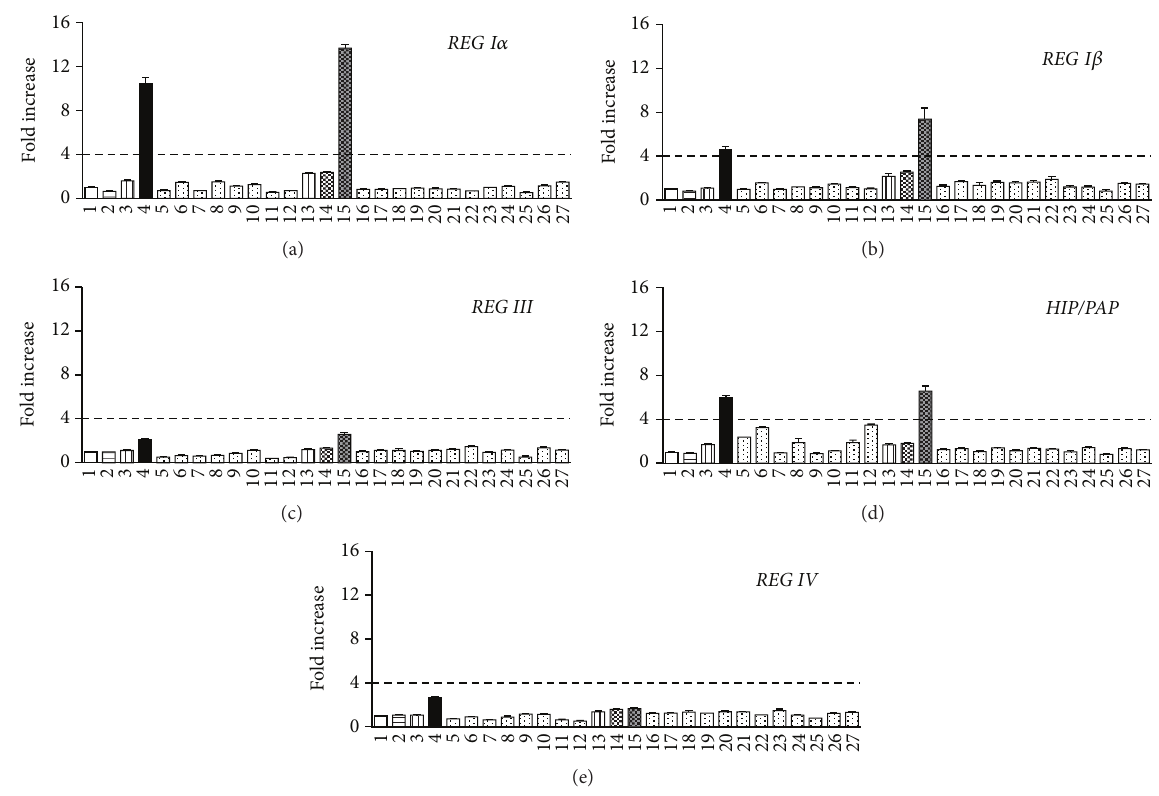
Figure 1: Effects of cytokines, 𝛽 -cell toxic agents, and growth factors on the transcription of (a) REG I 𝛼 , (b) REG I 𝛽 , (c) REG III, (d) HIP/PAP , and (e) REG IV in human 1.1B4 𝛽 cells. Cells were transfected with the human REG family gene reporter plasmids and treated as follows: 1, No addition; 2, Dx (100 nM); 3, IL-6 (20 ng/mL); 4, IL-6 + Dx; 5, IL-1 𝛽 (300 U/mL); 6, IL-1 𝛽 + Dx; 7, TNF- 𝛼 (370U/mL); 8, TNF- 𝛼 + Dx; 9, IFN- 𝛾 (100U/mL); 10, IFN- 𝛾 + Dx; 11, IL-1 𝛽 (60U/mL) + TNF- 𝛼 (185U/mL) + IFN- 𝛾 (14U/mL); 12, IL-1 𝛽 + TNF- 𝛼 + IFN- 𝛾 + Dx; 13, IL-22 (10ng/mL); 14, IL-22 + Dx; 15, IL-22 + IL-6 + Dx; 16, IFN- 𝛽 (1500U/mL); 17, IFN- 𝛽 + Dx; 18, IL-8 (100 nM); 19, IL-8 + Dx; 20, PDGF (1U/mL); 21, PDGF + Dx; 22, amino acids (5 times greater than that in RPMI 1640 medium); 23, palmitate (100 𝜇 M); 24, H 2 O 2 (10 𝜇 M); 25, SNAP (250 𝜇 M); 26, STZ (2mM); 27, STZ + Dx. The promoter activity was normalized for variations in transfection efficiency using 𝛽 -galactosidase activity as an internal standard. Fold increase is calculated by dividing the promoter activity of stimulated cells by that of unstimulated cells (column 1). The broken line corresponds to 4-fold increase. Data are expressed as means ± SE for each group ((a) 𝑁 = 3 - 4, (b–e) 𝑁 = 3 ). Transcriptional activities of no. 4 and 15 (IL-6 + Dx and IL-22 + IL-6 + Dx) in panels (a), (b), and (d) were significantly ( 𝑃 < 0.005 ) and prominently (over 4 fold)